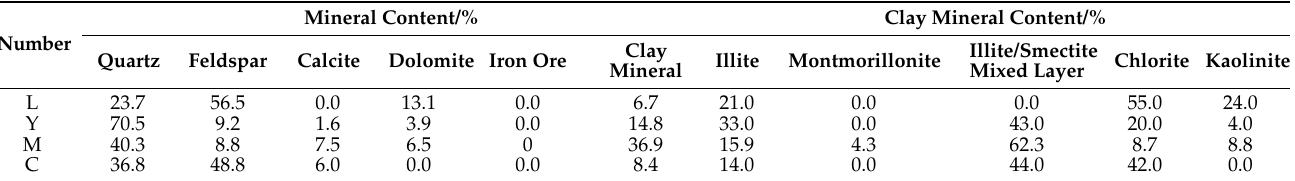
Table 2. Whole-rock minerals and clay minerals contents.